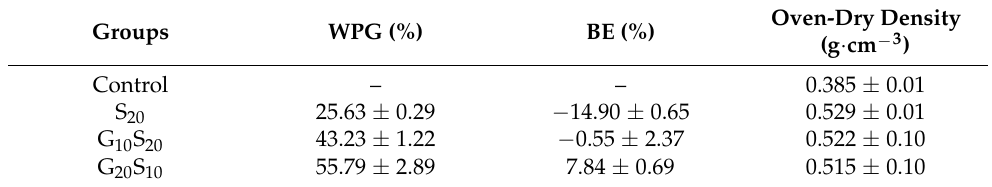
Oven-Dry Density (g · cm − 3 )